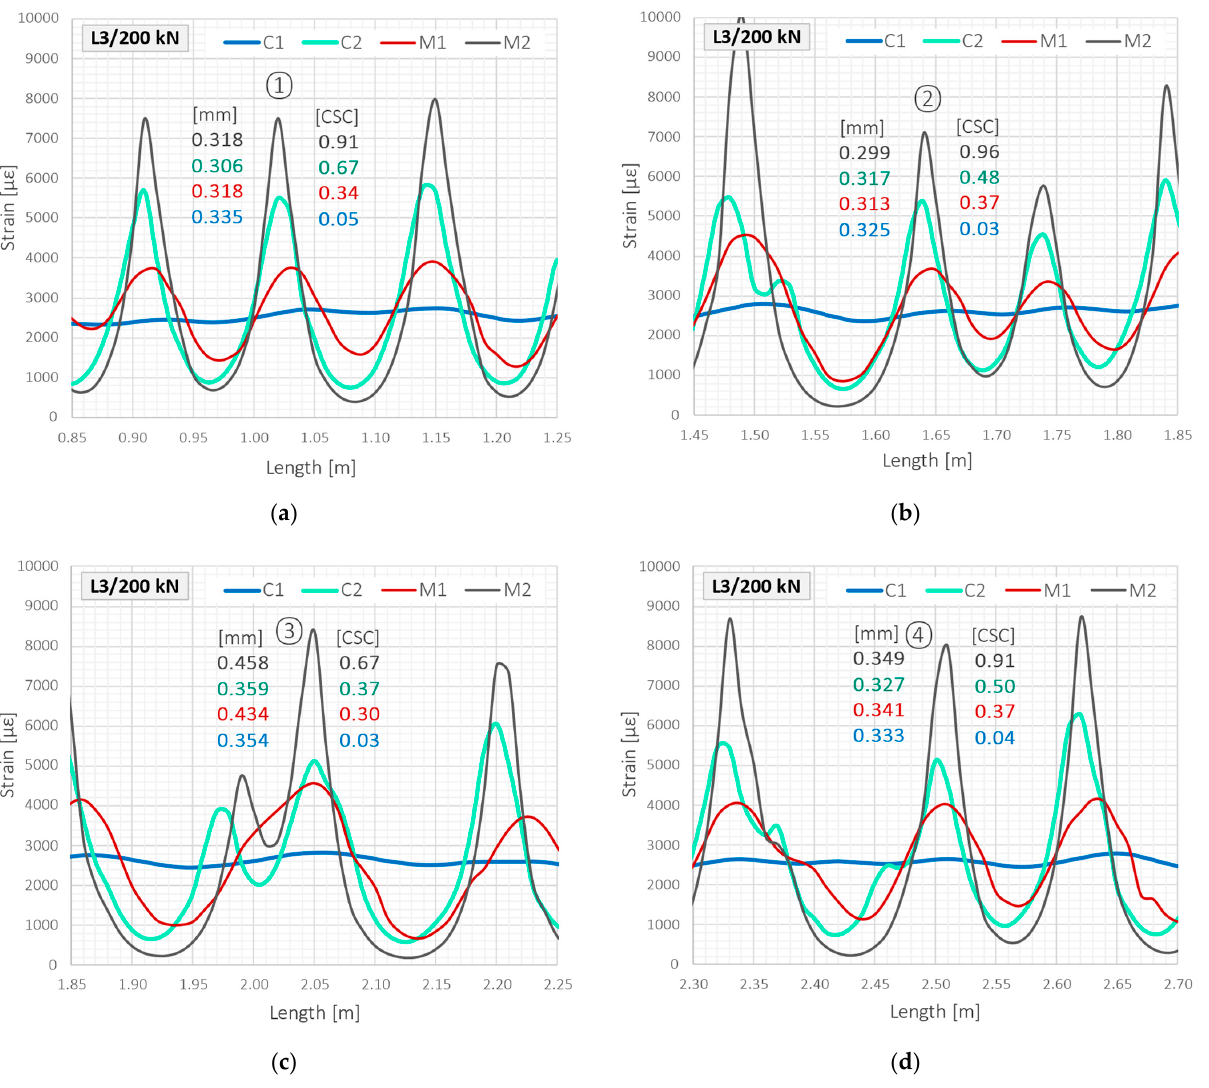
Figure 27. Beam L3/tension zone: close-up to the strain peaks in the load step no. 53 and force of 200 kN for: ( a ) crack no. ① ; ( b ) crack no. ② ; ( c ) crack no. ③ ; ( d ) crack no. ④ .